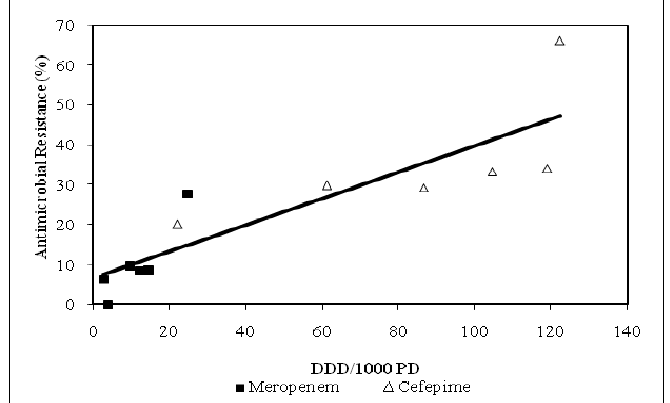
Figure 4. Relationship between cefepime vs. meropenem utilization and resistance among P. aeruginosa isolates: July-December 2005, Unit-specific (R = 0.87, p < 0.001).